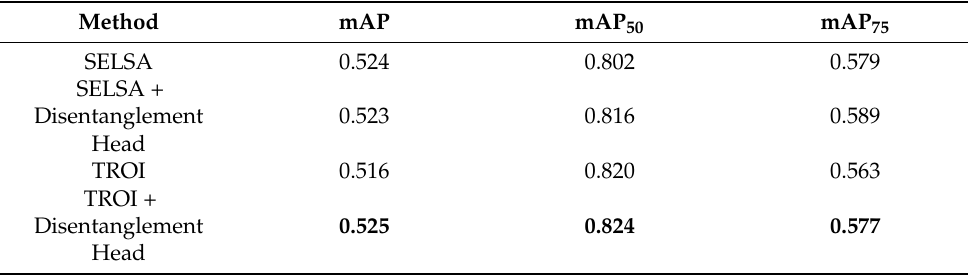
Table 5. Comparison of the proposed framework against the baseline using ResNet-101.